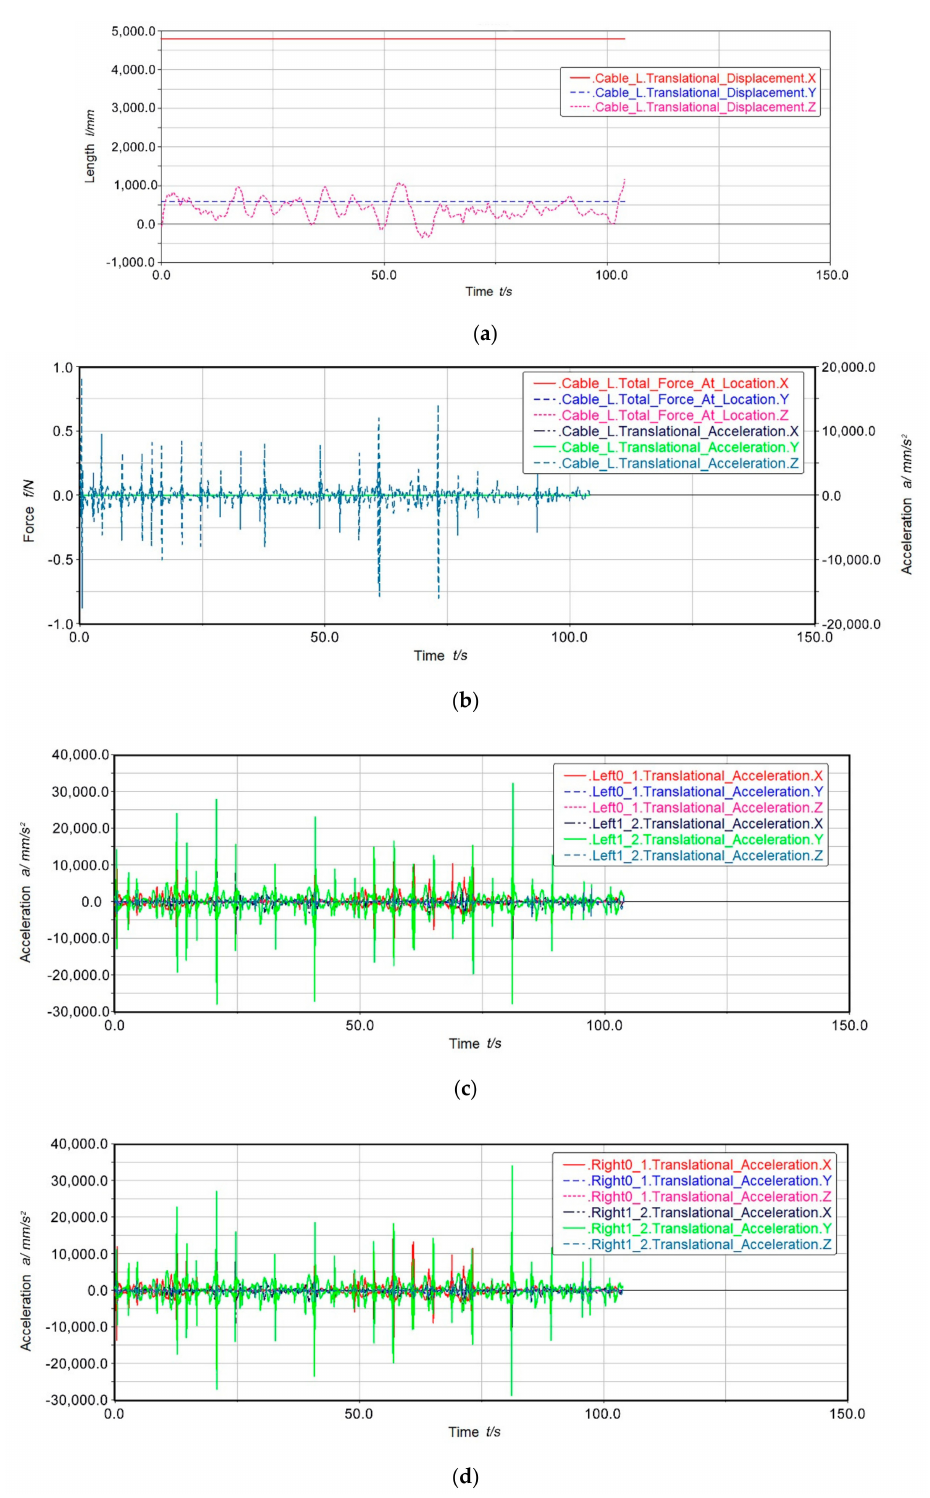
Figure 14. ( a ) Displacement at the left link; ( b ) force and acceleration at the left link; ( c ) accelerations at the left joints; ( d ) acceleration at each joint on the